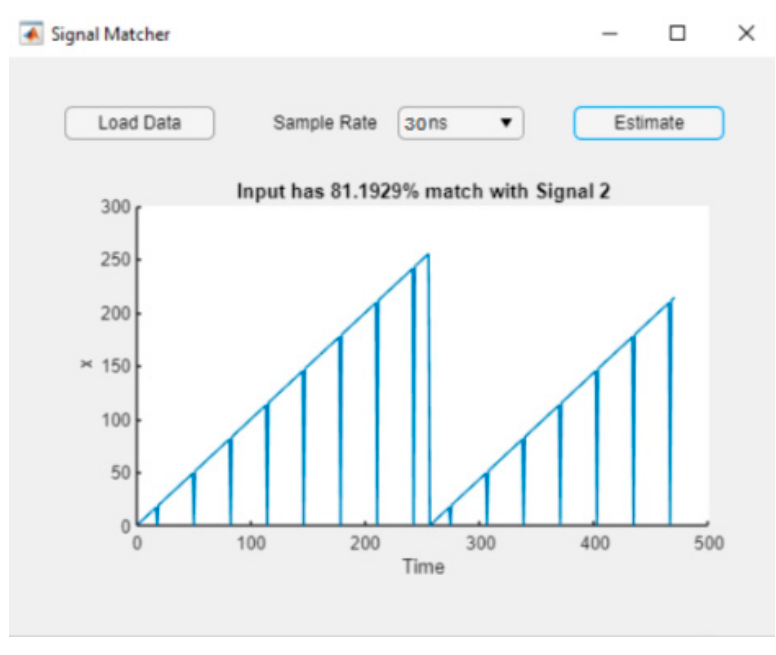
Figure 14. Comparison result of P3 running on 30 ns.